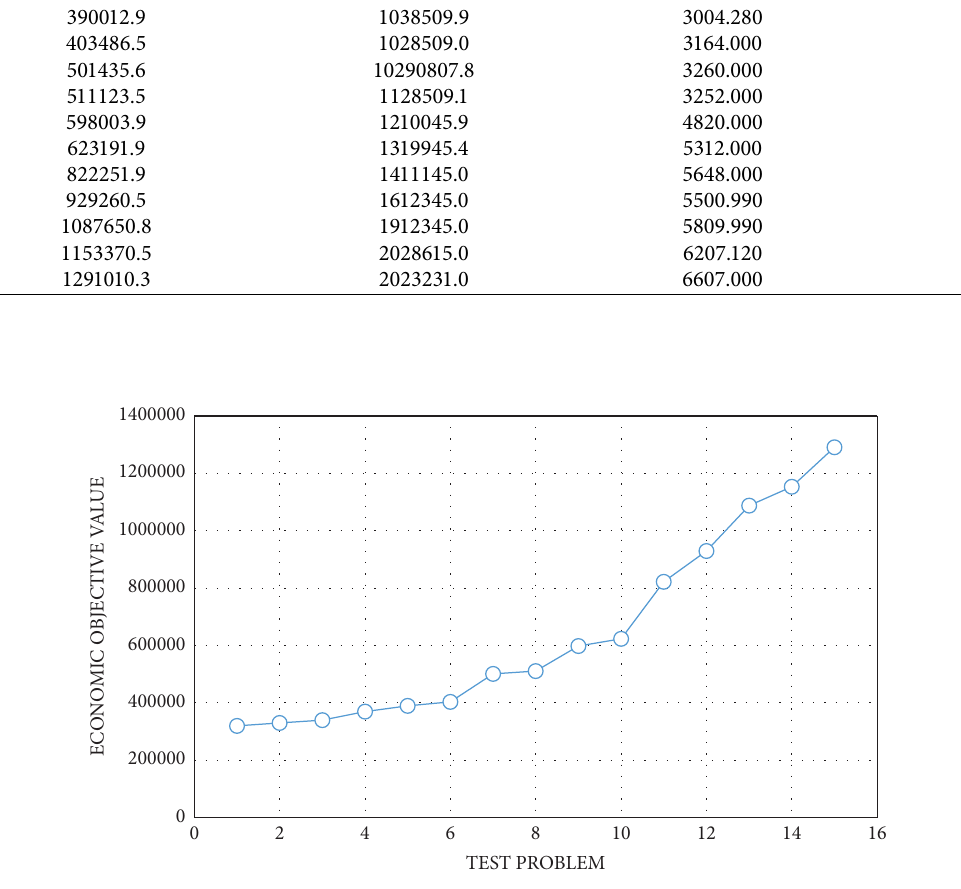
Figure 13: The value of the economics OF with different